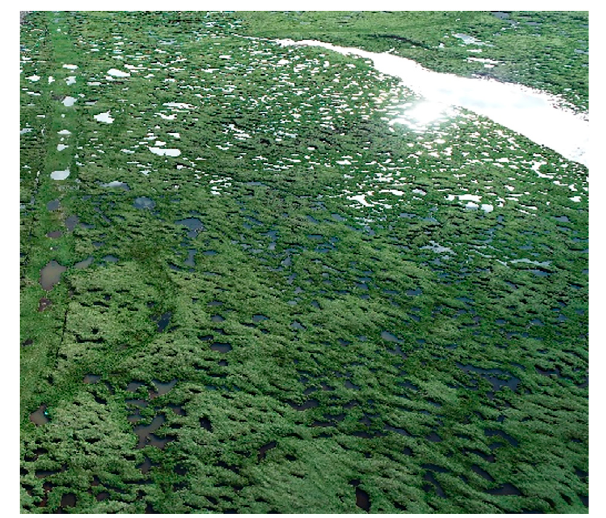
FIGURE 1 | Permafrost wetlands on the Qinghai – Tibet